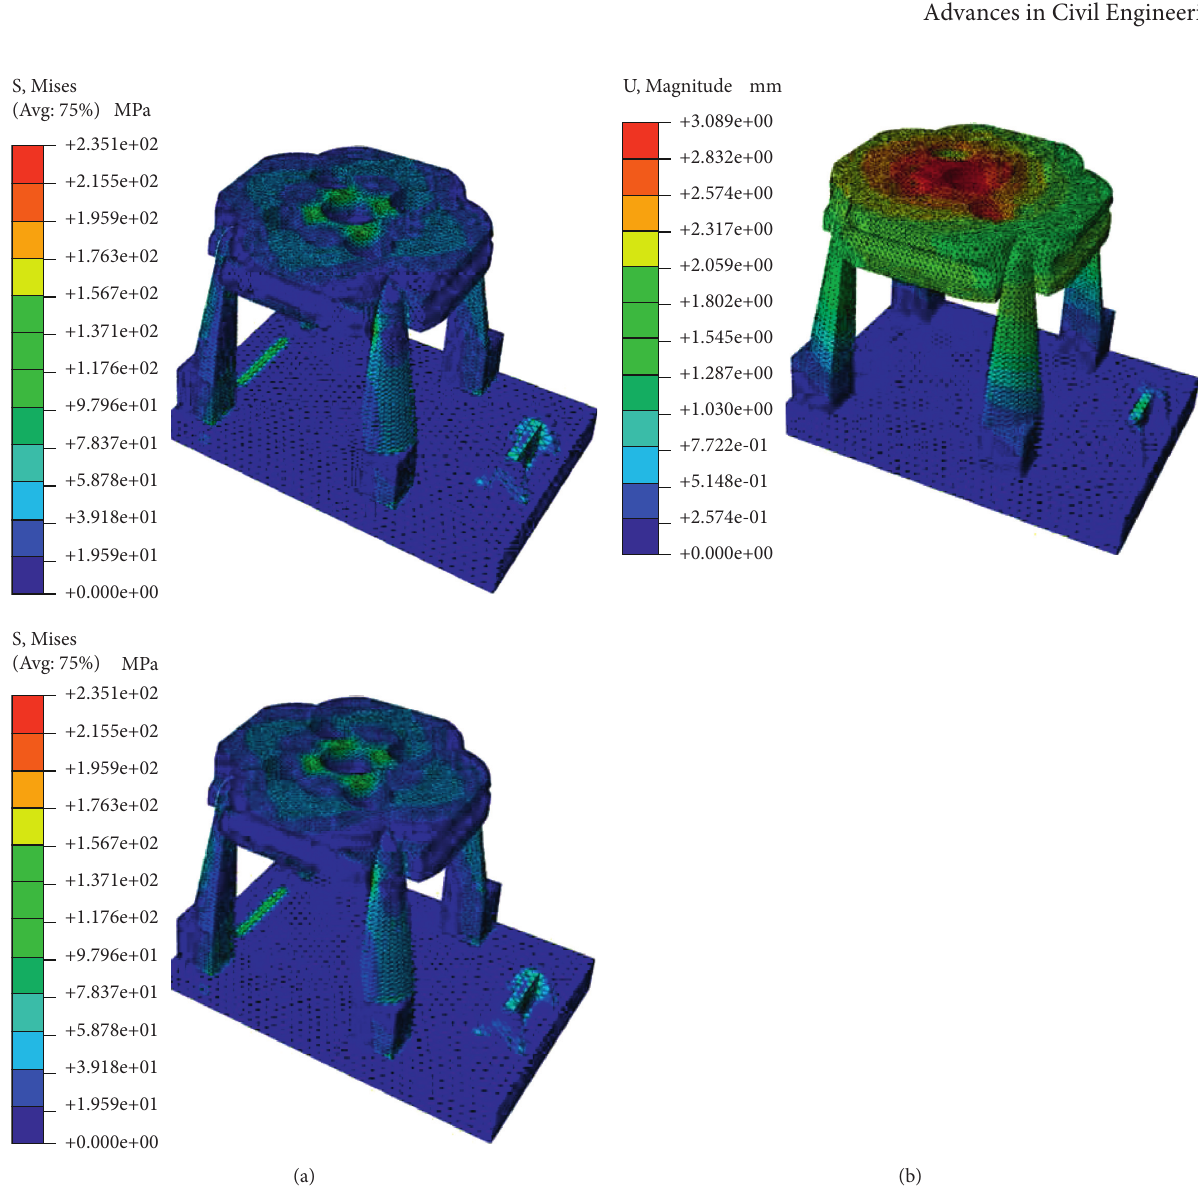
Figure 7: Stress and displacement cloud diagram of the optimized compression-shear test machine frame under the ultimate working conditions. (a) Stress cloud diagram. (b) Displacement cloud